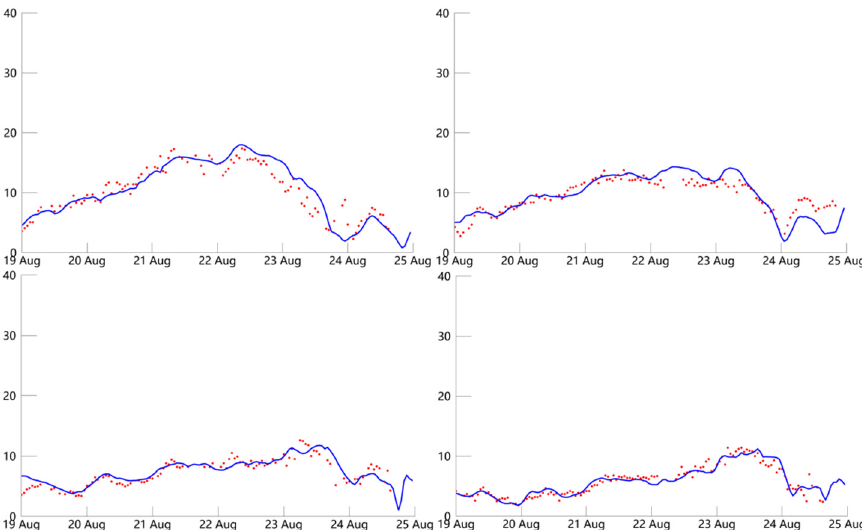
Figure 3. The temporal distributions of the wind speeds (m/s) obtained from experiment 19 (blue line) and the buoy observations (red dot) during typhoon Goni at the locations of four buoys.